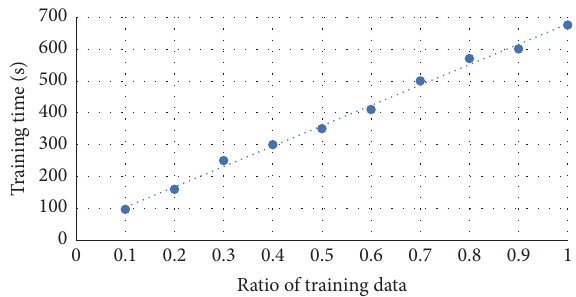
Figure 10: Training time of the proposed method on different data proportions. Table 6: Evaluation parameters for the Taobao dataset.